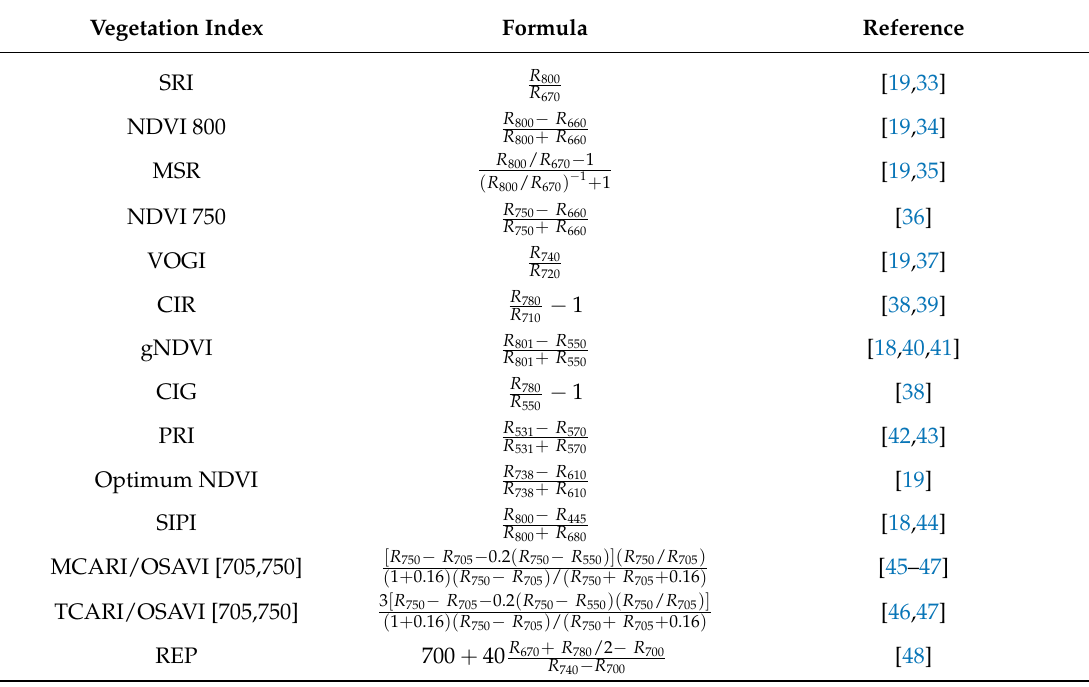
Table A1. Formulae for all hyperspectral vegetation indices used for the hyperspectral analysis. R n refers to the band number